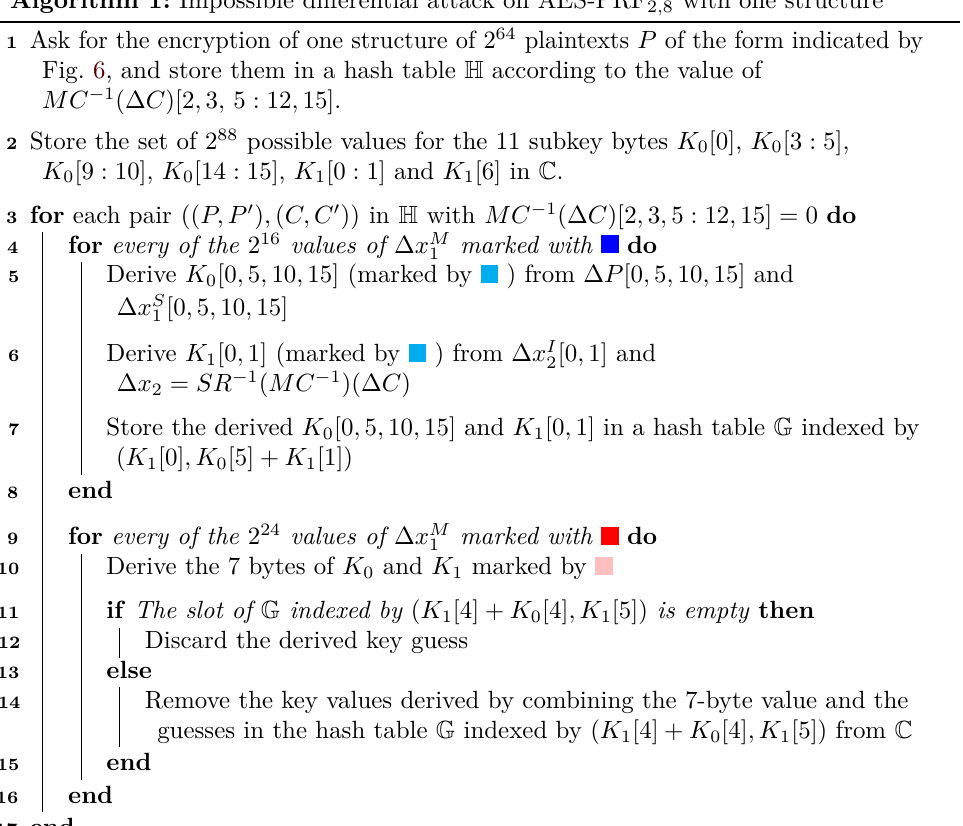
Algorithm 1: Impossible differential attack on AES-PRF 2 , 8 with one